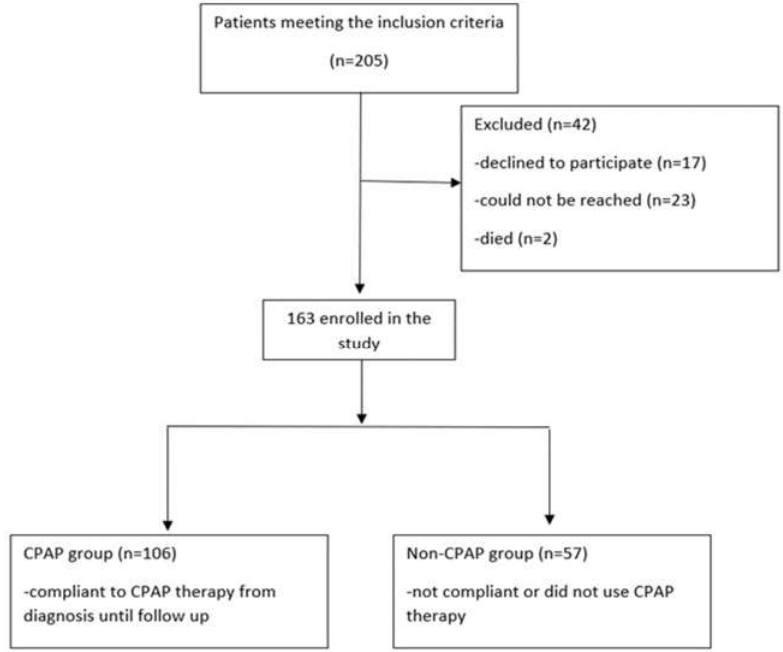
Figure 1. Study flow chart .